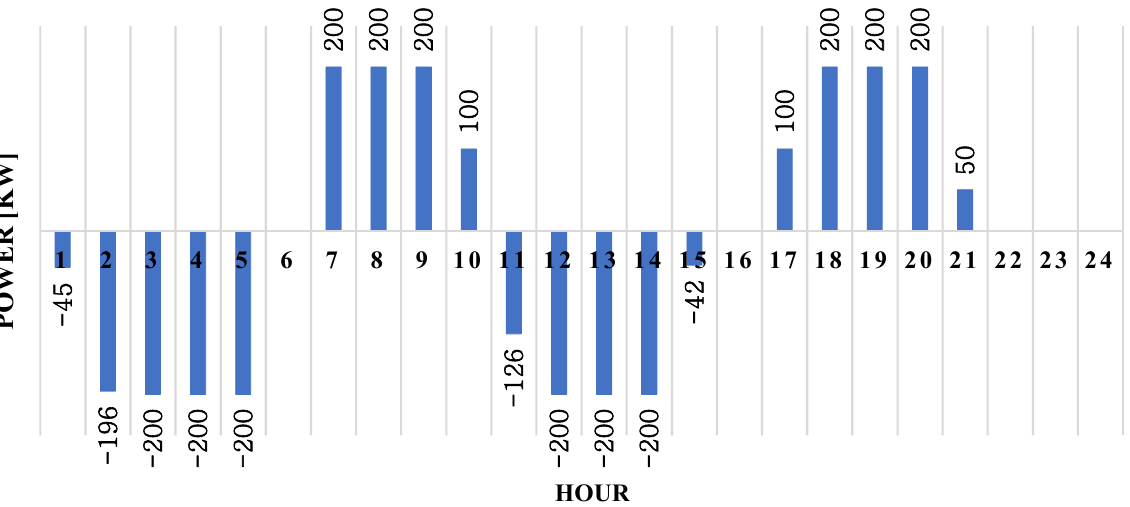
Figure 8. Hourly power profile of the MCS battery (positive = discharging and negative = charging).